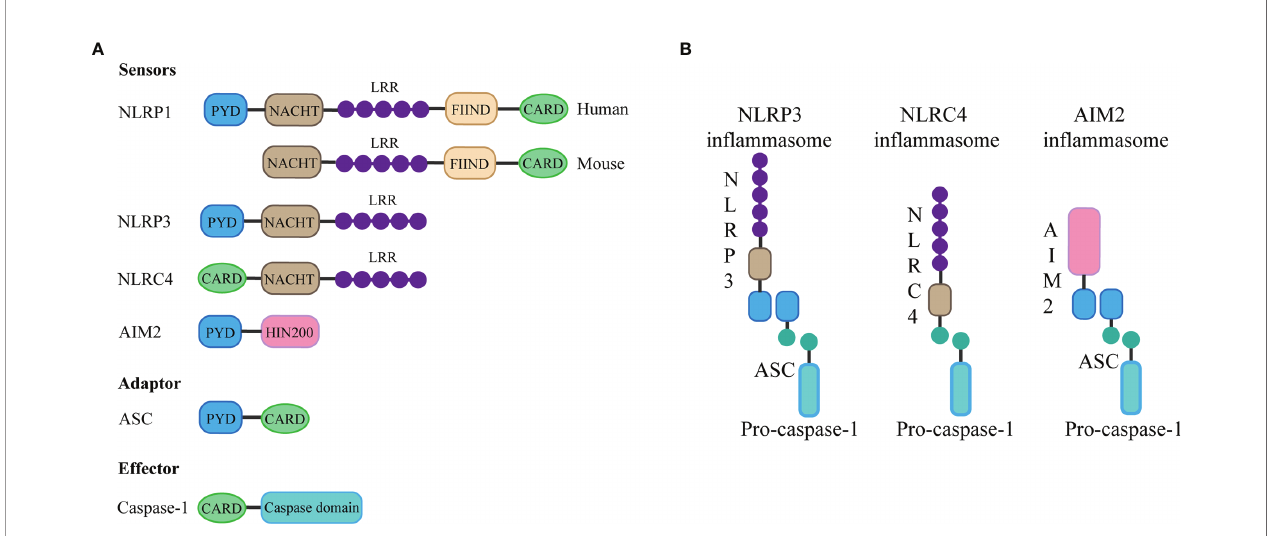
FIGURE 1 | Components and structure of in fl ammasomes. (A) The basic structure of most in fl ammasomes is based on the NOD-like receptor or ALR protein family as the sensor protein, ASC as the adaptor protein, and pro-caspase as the effector protein. Different sensor proteins consist of different domains: PYD, NACHT, LRR, function-to- fi nd domains (FIIND), CARD, and HIN domain. (B) The PYD domain of NLRP3 or AIM2 interacts with the PYD domain of ASC, while the CARD domain of ASC can be combined with the CARD domain of the effector protein pro-caspase-1 to form in fl ammasome. NLRC4 does not contain the PYD domain but contains the CARD domain, which means that it can directly connect through the CARD domain with the CARD domain of the effector